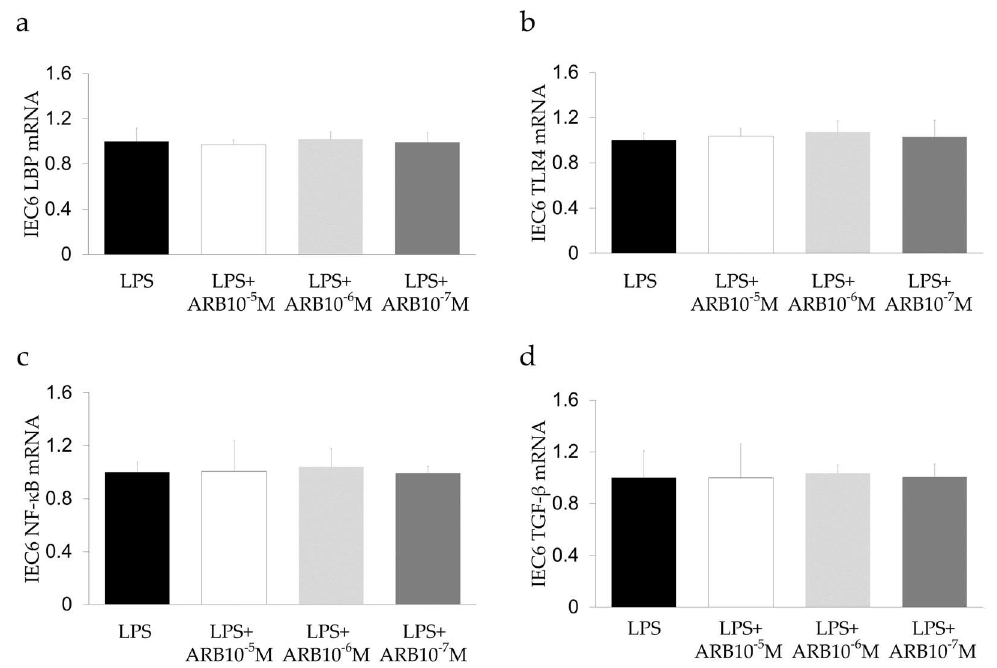
Figure 6. In vitro study of the effect of an ARB on intestinal epithelial cells using IEC-6. ( a ) LBP, ( b ) TLR4, ( c ) NF-kB, and ( d ) TGF-β. ARB did not influence IEC-6.